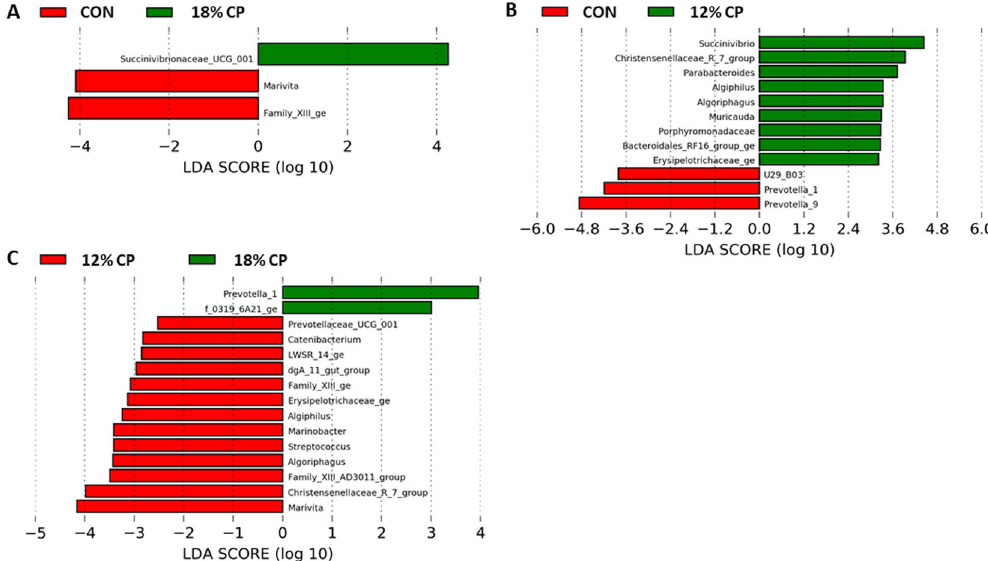
Figure 5. Effect of low protein diets on fecal microbiota composition at genus level using linear discriminant analysis (LDA) with effect size (LEfSe). ( A ) CON vs. 18% crude protein (CP), ( B ) CON vs. 12% CP, ( C ) 12% CP vs. 18% CP. CON, control diet with 24% CP; 18% CP, low protein diet with 18% CP; 12% CP, low protein diet with 12% CP. n = 7, n = 7, n = 8 for CON, 18% CP and 12% CP groups,